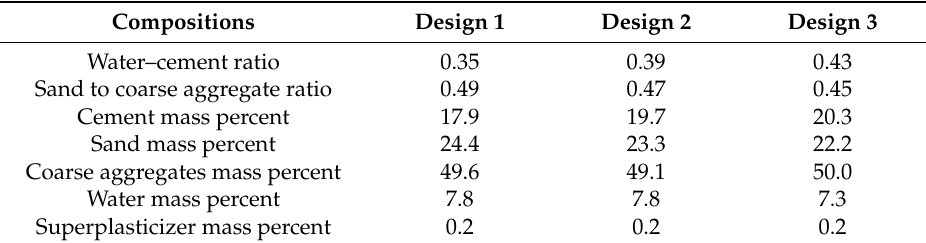
Table 2. The gradation of coarse and fine